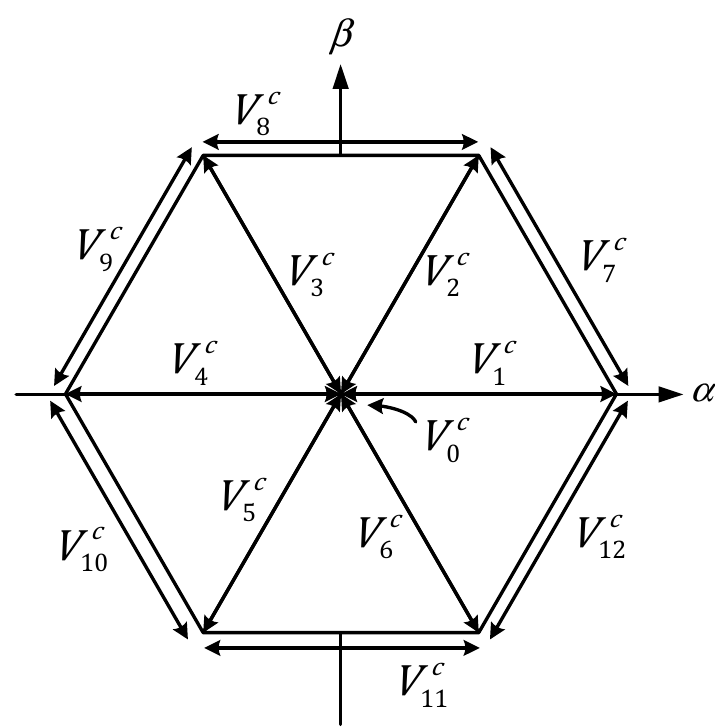
Figure 5. Distribution of thirteen synthesized voltage vectors.